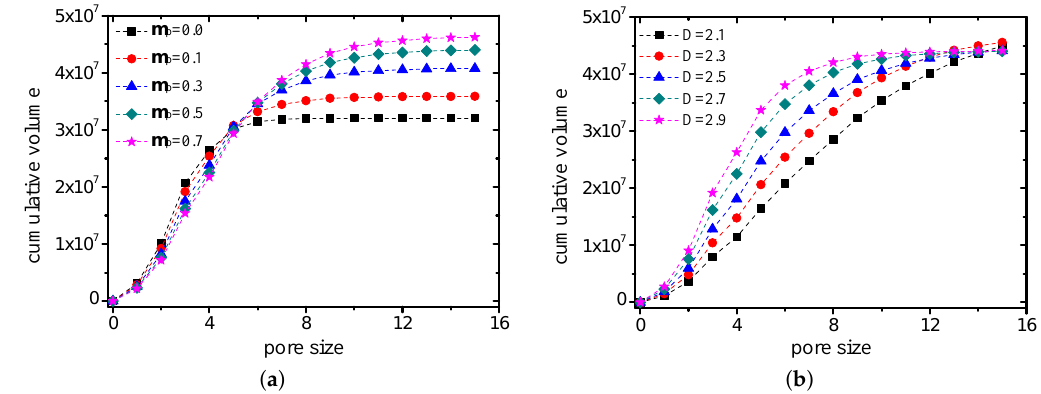
Figure 21. Volume accumulation curves for pore size (( a ) D is 2.5, while the friction coefficient takes different values; ( b ) µ p is 0.5, while the fractal dimension takes different values).